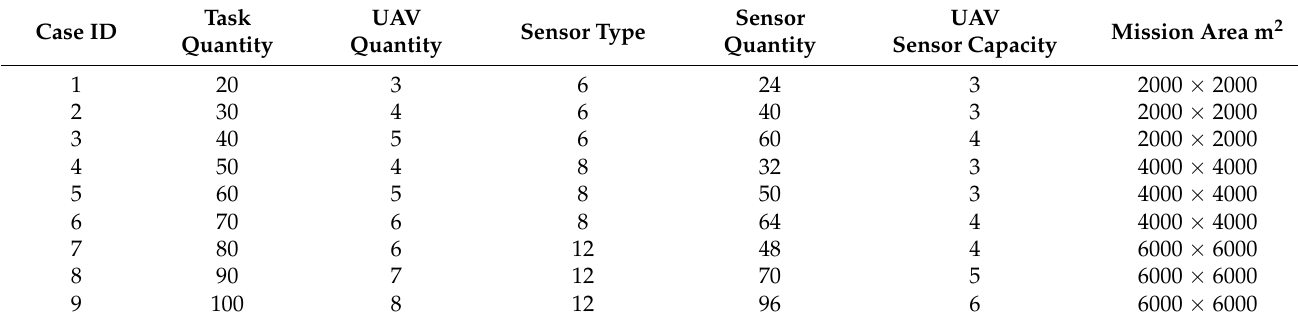
Table 6. Summary of the test